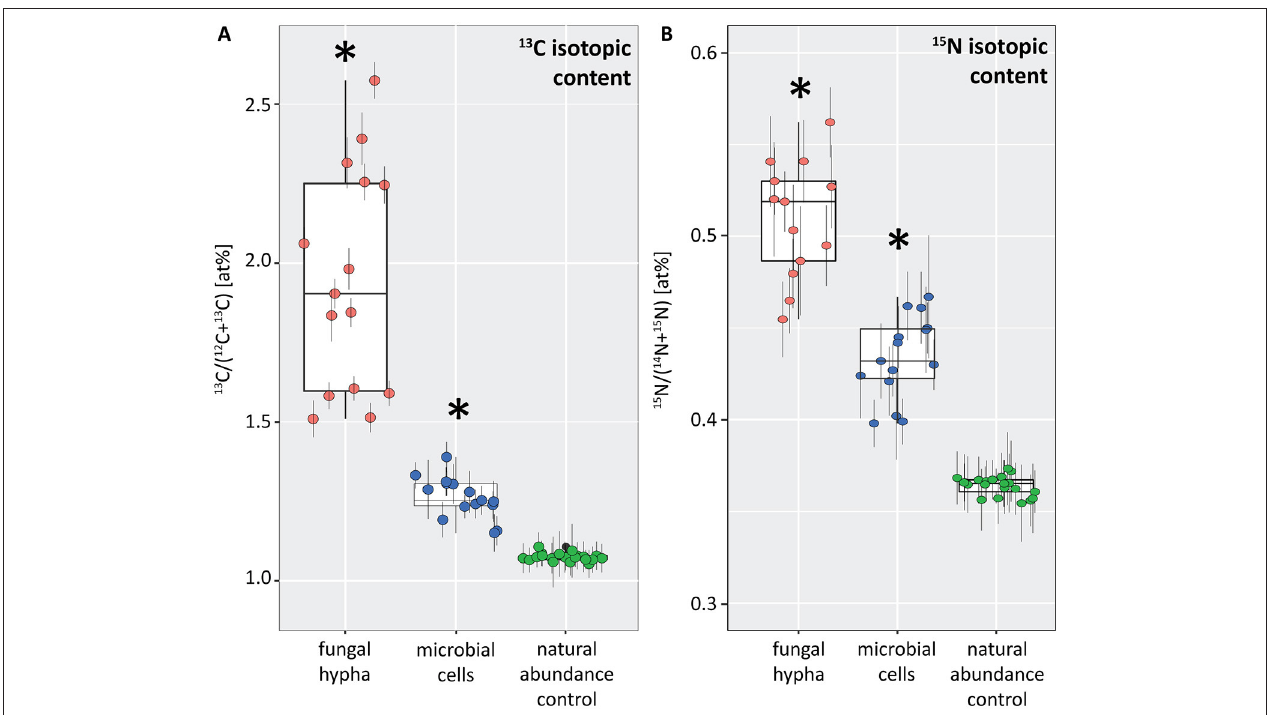
FIGURE 6 | Boxplots depicting the 13 C (A) and 15 N (B) isotopic content (in atom%) for a fungal hypha (displayed in Figure 5 ) and hyphosphere microorganisms (displayed in Figure 7 ) from dual-labeled plant-boxes, along with the values obtained from measurement on the natural abundance control. Each data point represents an individual region of interest (ROI) extracted from NanoSIMS images depicted in Figures 5 , 7 , error bars refer to the estimated analytical uncertainty (1 σ ) due to counting statistics (see section Materials and Methods). Significant levels of isotopic enrichment ( p < 0.001) are indicated with an asterisk (*). Data for the natural abundance control were obtained from microbial cells associated to the surface of a hypha extracted from a non-labeled control box. With respect to the values of the fungal hypha it should be noted that these refer to the averages over 19 consecutive scans. Owing to the observed variation of enrichment within the z-stack (see Animation S1 ), the displayed maxima rather represent conservative